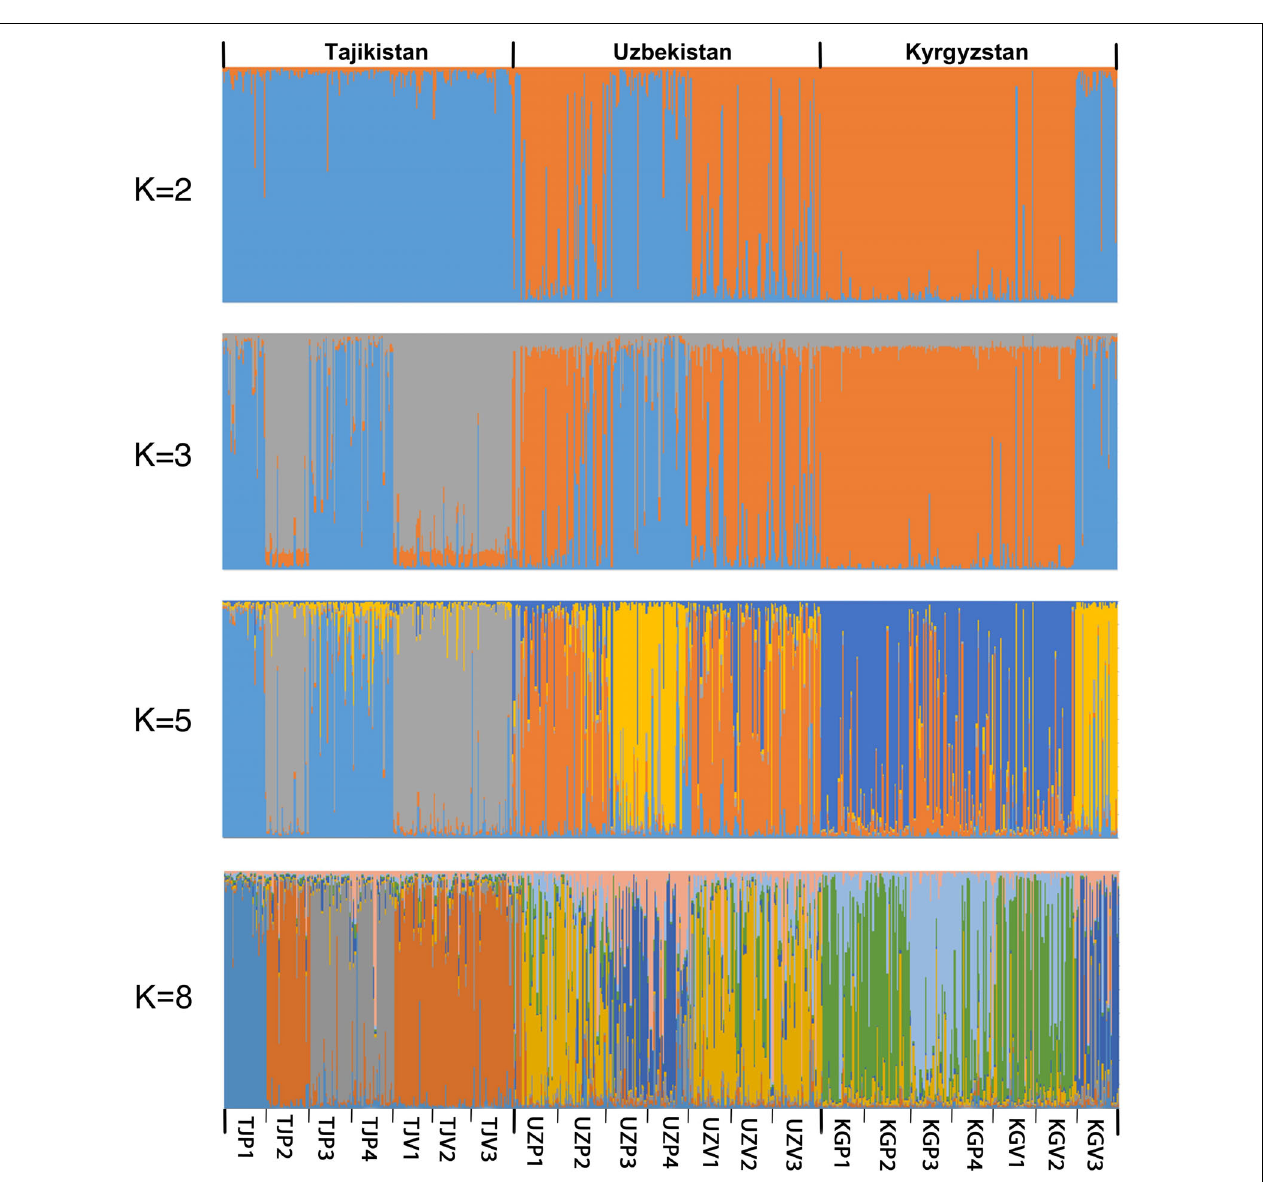
FIGURE 3 | Population structure inference for 624 Central Asia walnut samples in Structure v2.3.4. Each genotype is represented by a vertical colored line. Colors represent the membership of each individual to the different clusters.